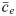
Reconstructed apparent extracellular ion concentration c¯e and low-frequency mean conductivity σL as β changes.(a) Apparent extracellular ion concentration images by changing β value from 0.31 to 0.56 (first row) and the difference images of c¯e(β)-c¯e(β=0.41) (second row), respectively. (b) Low-frequency conductivity images by changing β value from 0.31 to 0.56 (first row) and the difference images of σL(β) − σL(β = 0.41) (second row), respectively.